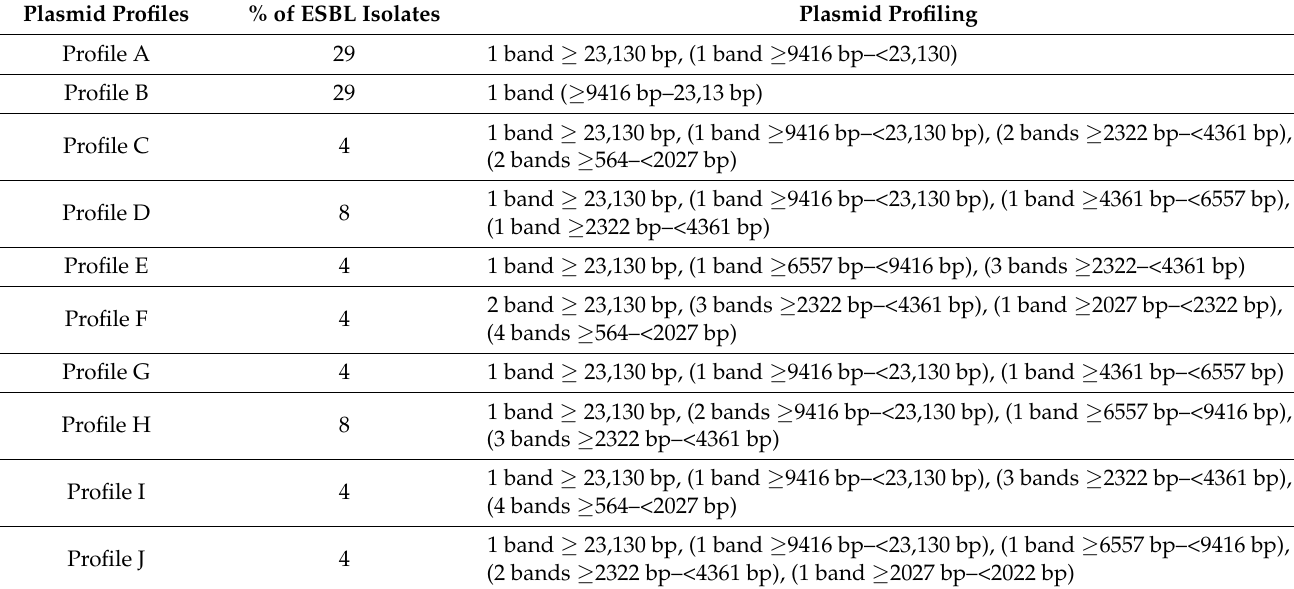
Table 3. Plasmid profiles found in ESBL-positive MDR- A. baumannii